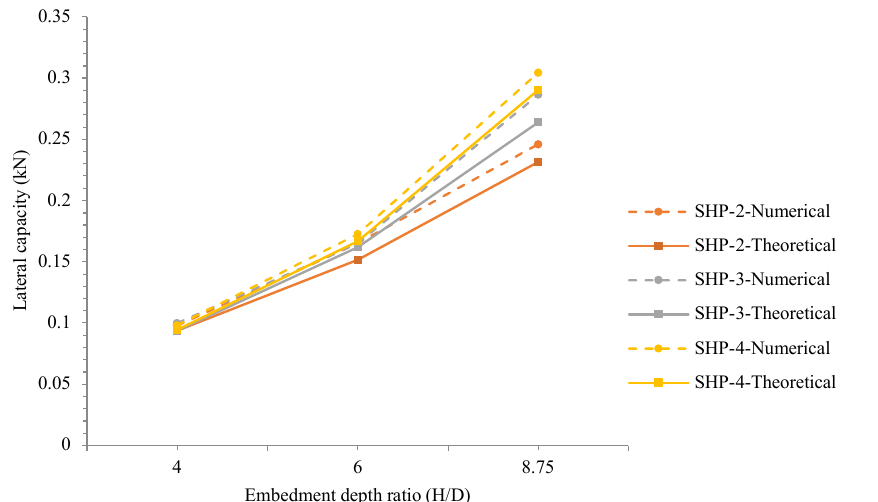
Figure 10. Comparison between theoretical and numerical results—Lateral loading. The maximum percentage variation is found to be 5% and 8% in the cases of uplift and lateral tests, respectively. In the case of lateral loading, the embedment depth ratio and the number of plates influence the capacity values significantly. In addition, increasing the eccentricity of loading decreases the lateral capacity substantially. When comparing the lateral capacity of the four-plated helical pile to that of the one-plated helical pile, a maximum of a 48% increase is observed. The reason behind this may be that increasing the number of helical plates increases the bearing resistance and uplift resistance, which leads to an increase in capacity. Figure 11a,b show the comparison of the load–displacement curve for experimental and numerical results of uplift loading.